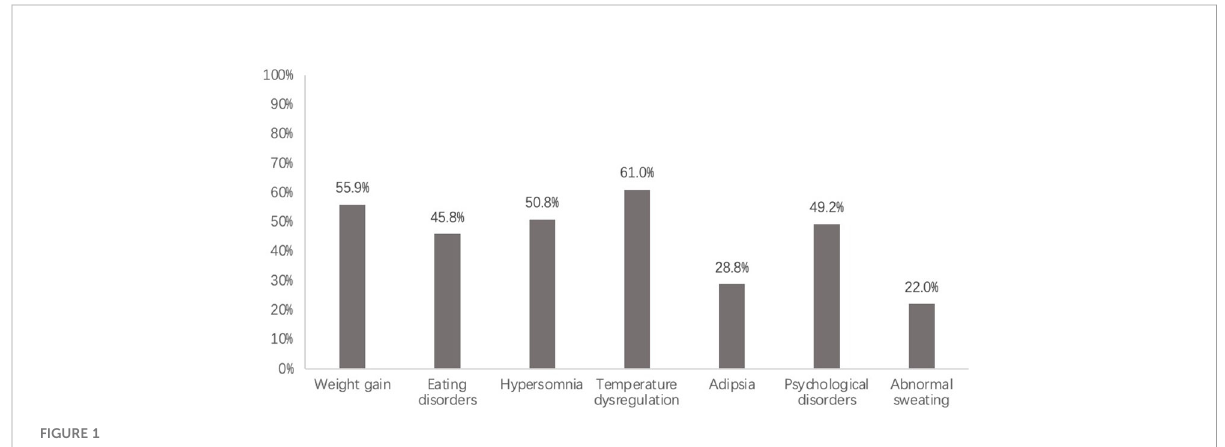
FIGURE 1 Clinical symptoms of adults with hypothalamic dysfunction. Data given at no. (%).